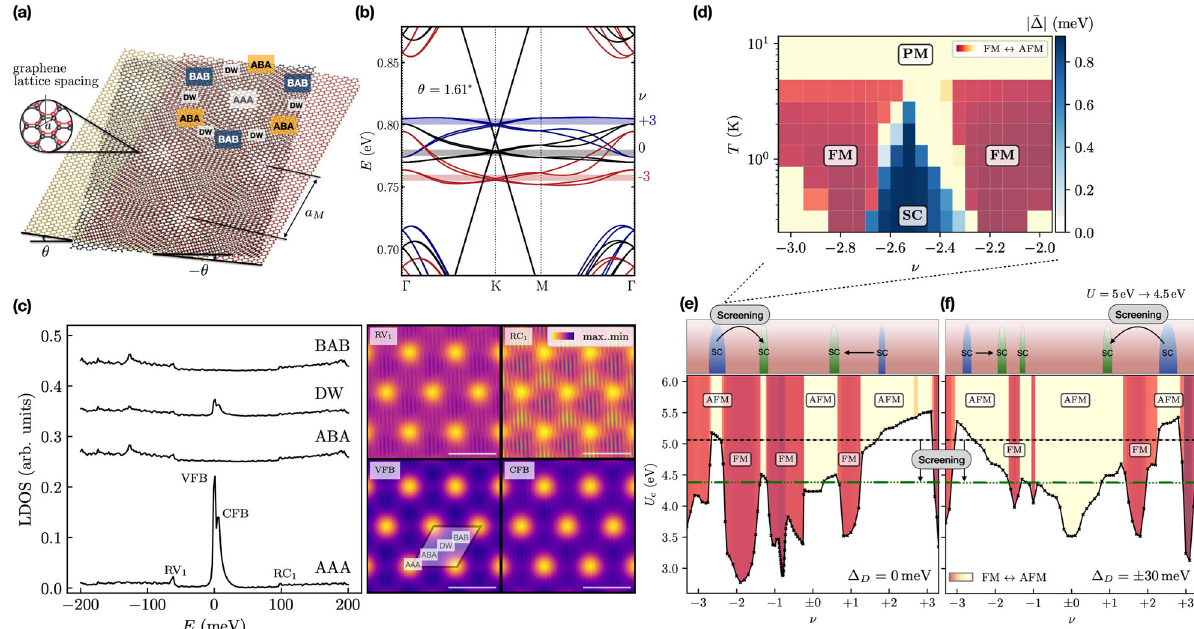
Fig. 1 Unconventional superconductivity in magic-angle twisted trilayer graphene (MATTG). a The atomic structure of MATTG consists of three superimposed graphene sheets. While the outer graphene sheets are aligned (AA stacked) and untwisted, the inner layer (black) is twisted at an angle θ ( − θ ) relative to the lower (upper) sheet. b Band structure of MATTG at θ = 1.61°. Long-range electron – electron interactions are taken into account through Hartree corrections that lead to a doping-dependent band structure. The fl at band dispersion is strongly affected by the fi lling factor ν (blue: ν = + 3, black: ν = 0, red: ν = − 3), whereas the Dirac cone remains unaffected. c Local density of states (LDOS) in the outer layer of MATTG for ν = − 2.5. The left panel clearly shows that the fl at bands are mostly localized in the AAA regions. The right panel shows the spatial distribution of the LDOS in the top layer at energies of the remote valence band (RV 1 ), remote conduction band (RC 1 ), valence fl at band (VFB), and conduction fl at band (CFB), re fl ecting the C 3 z symmetry of the non-interacting Hamiltonian. d Phase diagram of MATTG for θ = 1.61° around ν = − 2.5. Our numerical calculations reveal a superconducting dome driven by low-energy AFM spin- ≈ 2 K. The average amplitude of the order fl uctuations that range from ν = − 2.35 to ν = − 2.7 with an upper critical temperature of T c parameter j Δ j is reduced with increasing temperature and vanishes toward the integer fi llings ν = − 3 and ν = − 2, where ferromagnetic phases (FM) dominate. At high temperatures, the system remains paramagnetic (PM). e , f Magnetic correlations in MATTG at zero (left) and nonzero = ±30 meV (right) perpendicular displacement fi eld. The lower panel displays the critical Hubbard interaction strength U Δ D c needed for the onset of magnetic order as a function of fi lling. The type of magnetic order is color-coded through an order parameter that continuously interpolates between AFM and FM order (red: FM, yellow: AFM, for a de fi nition, see Supplemental Methods). The upper panels display a sketch [which is con fi rmed quantitatively for fi lling between ν = − 3 and ν = − 2 in d ] of parameter regions that can host unconventional SC driven by AFM spin- fl uctuations for U ≈ 5 eV (dashed black horizontal line). As magnetic interactions can only provide the pairing glue for superconductivity as long as the system remains paramagnetic, i.e. U < U c , this mechanism supports SC at ν = − 2 − δ and around ν = + 2 + δ . Screening effects caused by the dielectric environment may change the position of the superconducting domes to different fi llings (blue to green SC domes). Applying an electric fi eld to the sample ( f ) enhances superconducting regions at the electron-doped side at ν = + 2 + δ